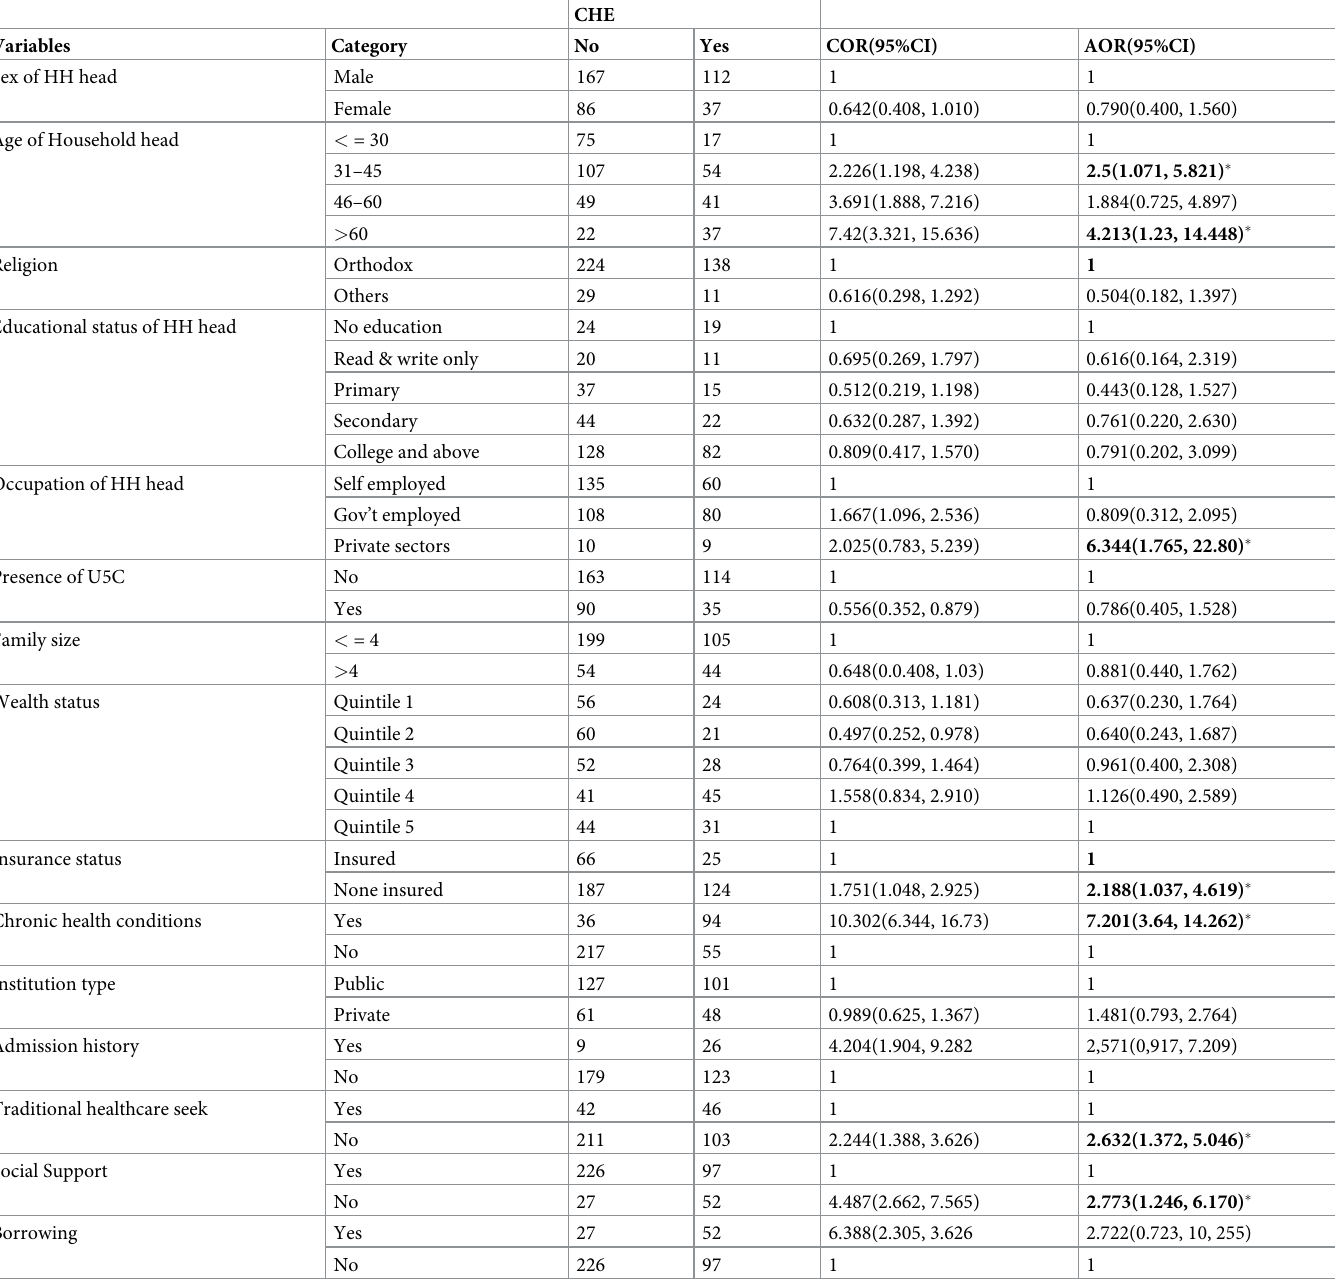
Table 6. Multiple regression of factors affecting catastrophic health expenditure among households in Debre Tabor town, 2022.